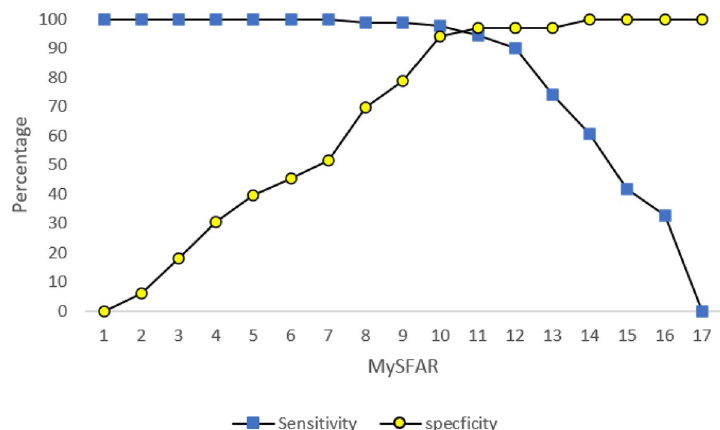
Fig. 3 Sensitivity and specificity of the Malaysian Version of Score for Allergic Rhinitis